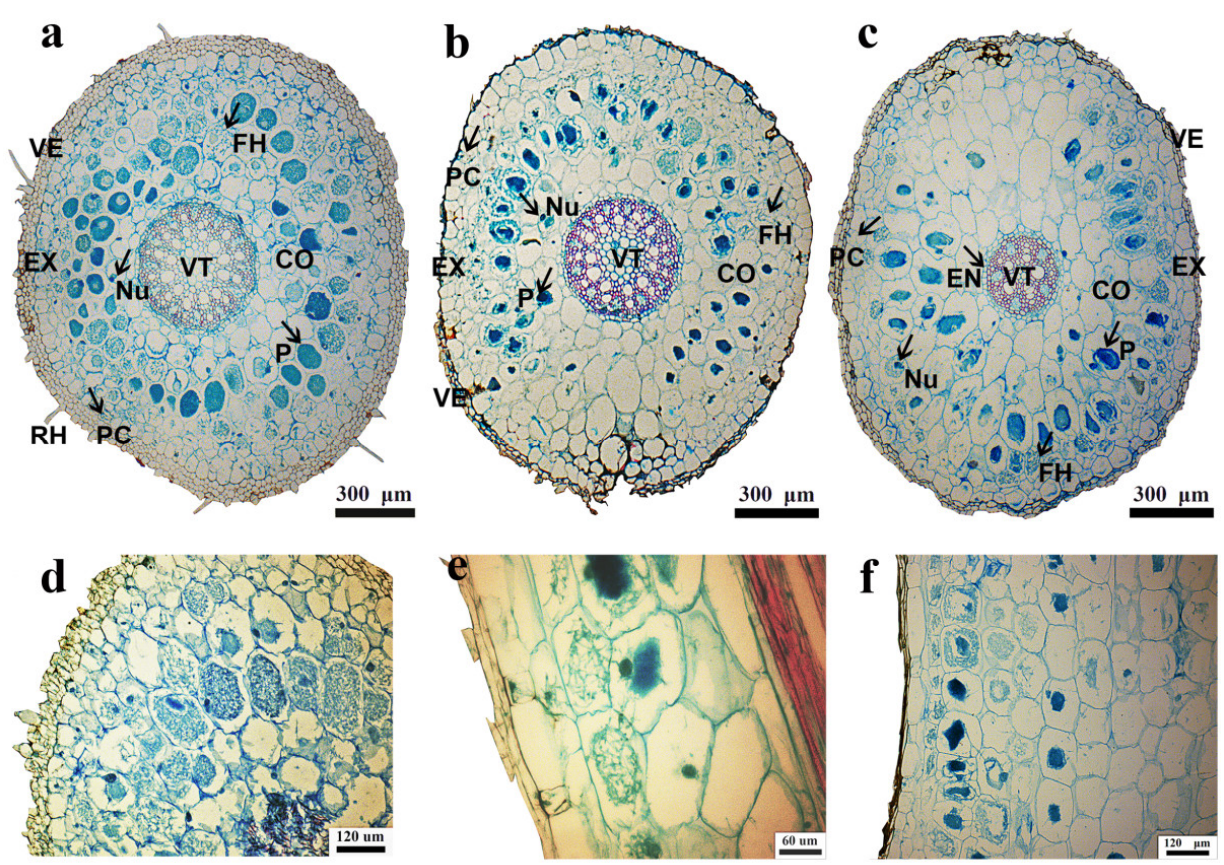
Figure 1. Root cross-sections and infection position of mycorrhizal fungi of B. striata ( a , d ), B. ochracea ( b , e ), and B. formosana ( c , f ). CO, cortex; EN, endodermis; EX, exodermis; FH, hyphae; P, phloem; PC: pathway cell; Nu: nucleus; VE: velamen; VT: vascular tissue; RH: root hair. The arrow points to pathway cell.